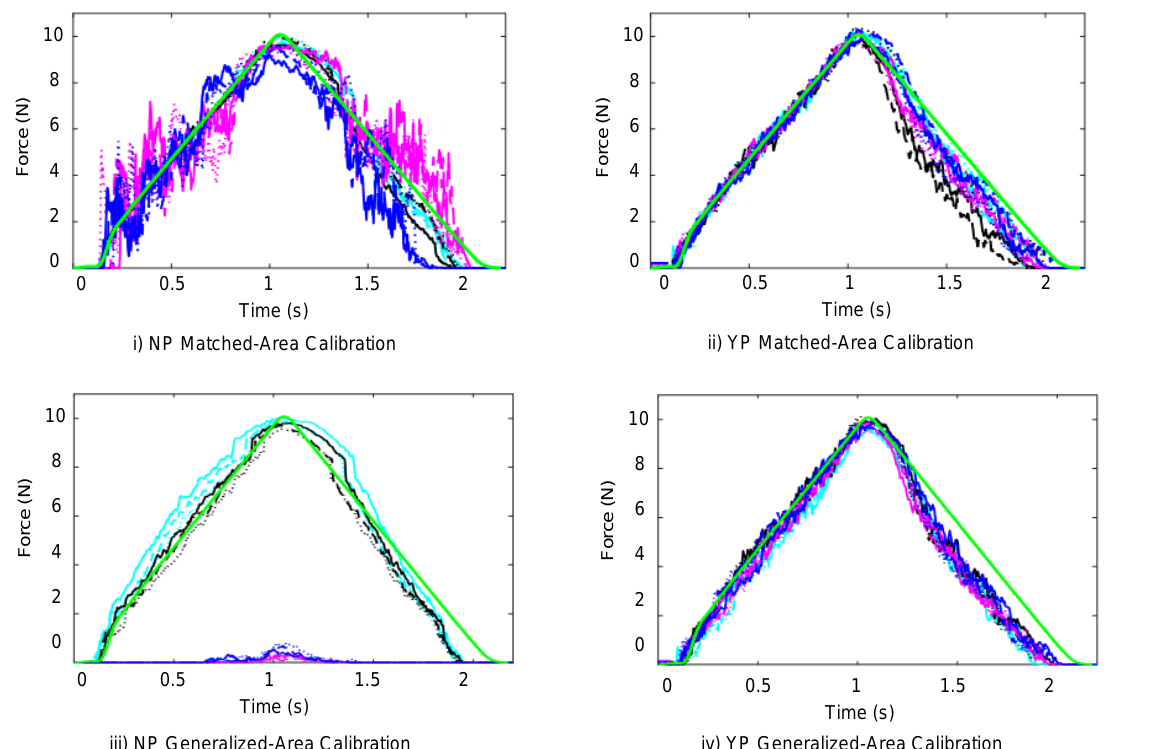
iv) YP Generalized-Area Calibrationiii) NP Generalized-Area Calibration